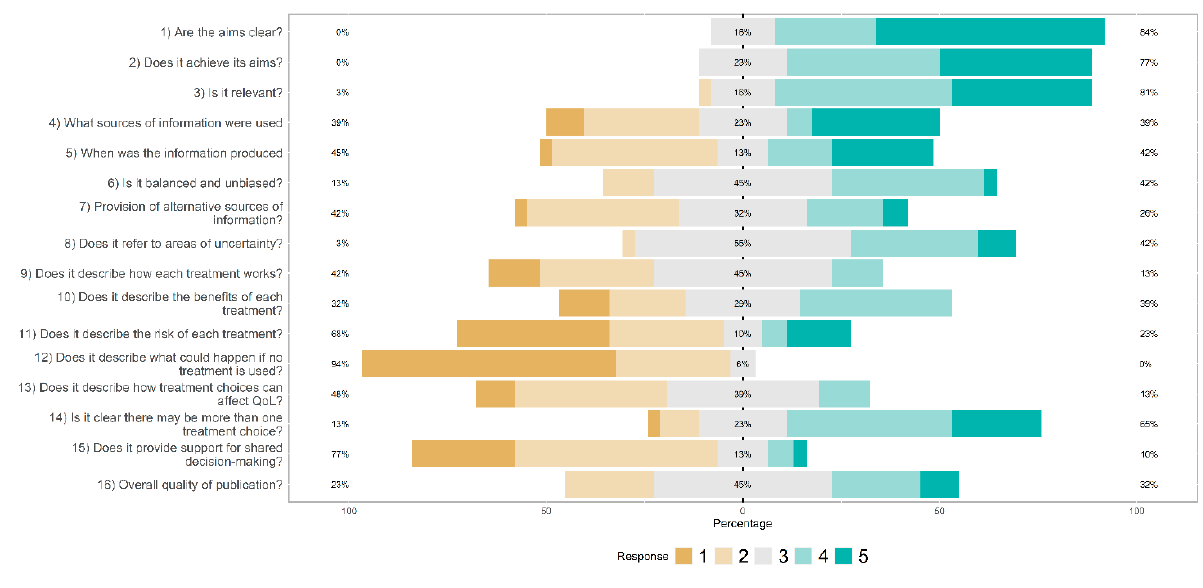
Figure 4. Distribution of DISCERN-scores combined and averaged across Italian websites (1 = low, 5 = high). Adapted from Charnock et al. [72].